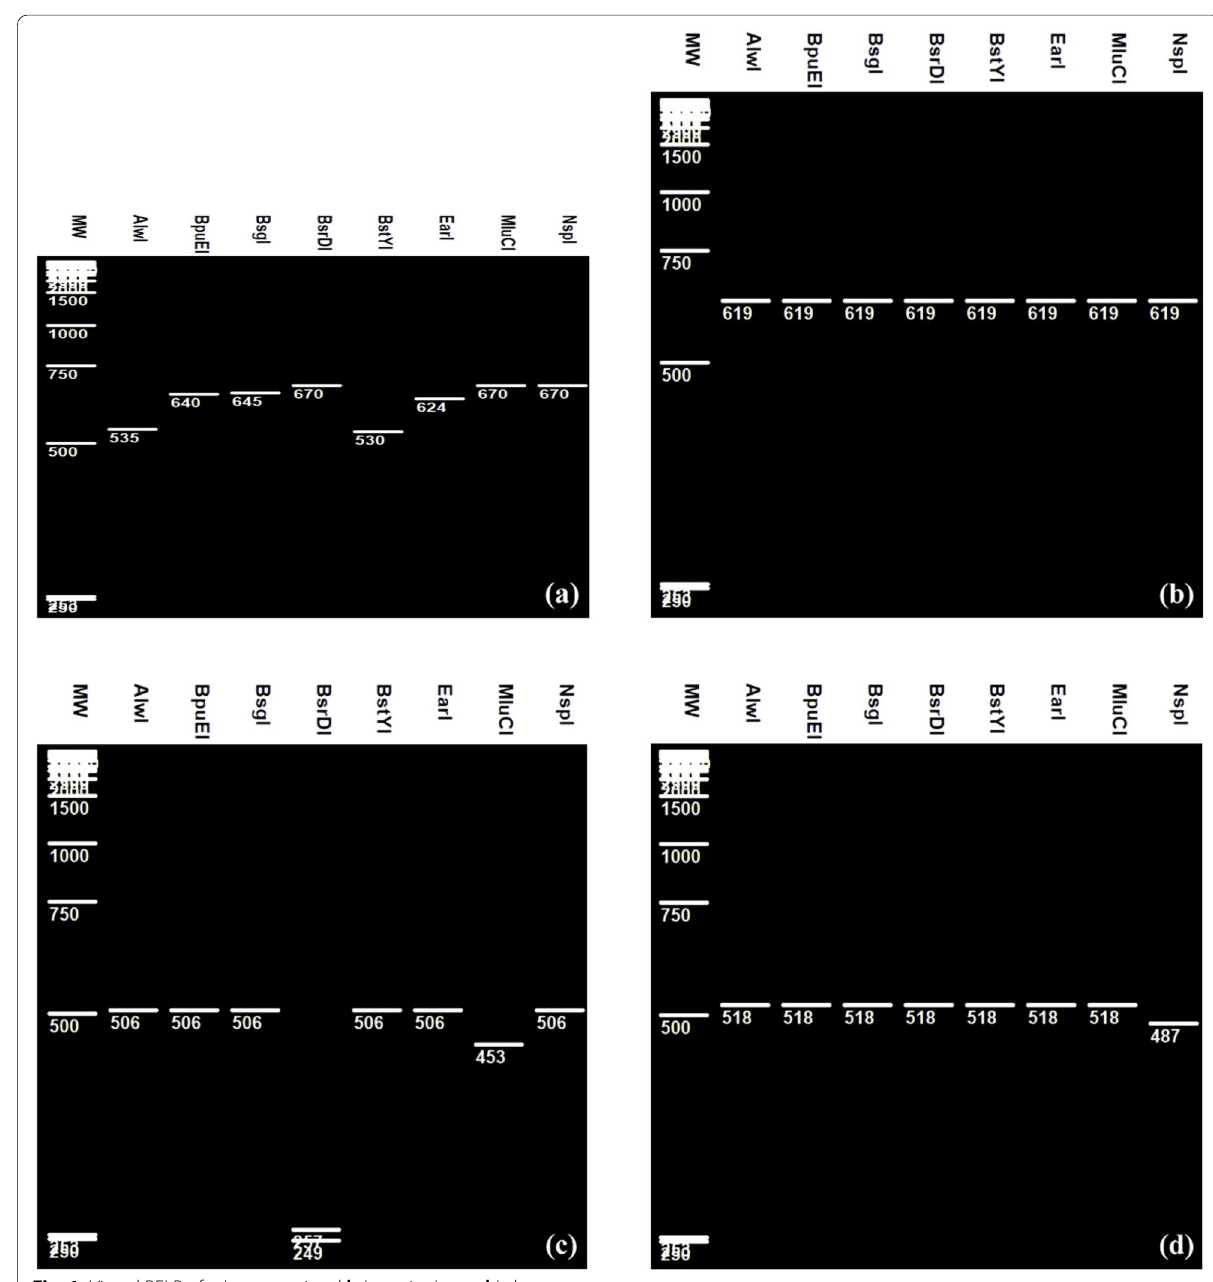
Fig. 1 Virtual RFLP of a L paracasei and b L casei , c L zea , d L